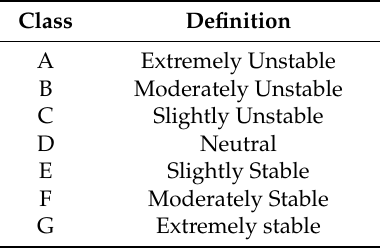
Table 1. Pasquill-Gifford Class